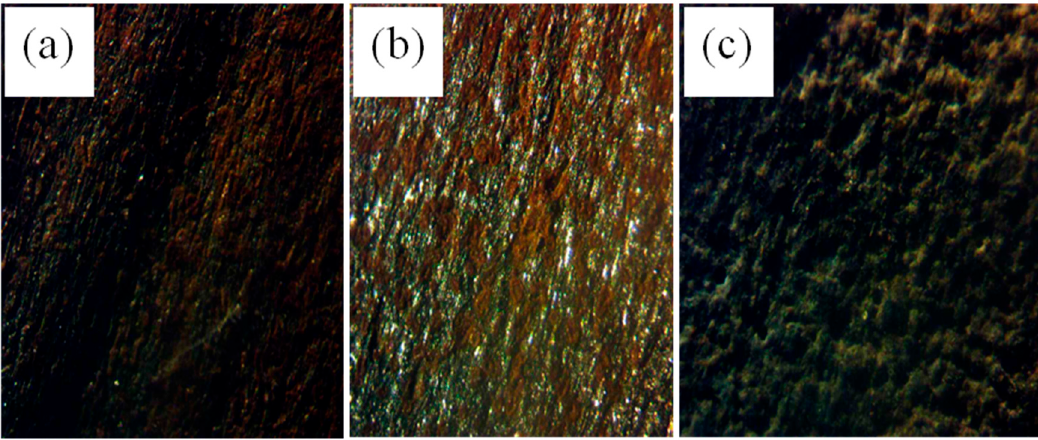
Figure 5. Optical images of metal cap of porcelain insulators; ( a ) 50 years, ( b ) 30 years, ( c ) 10 years.